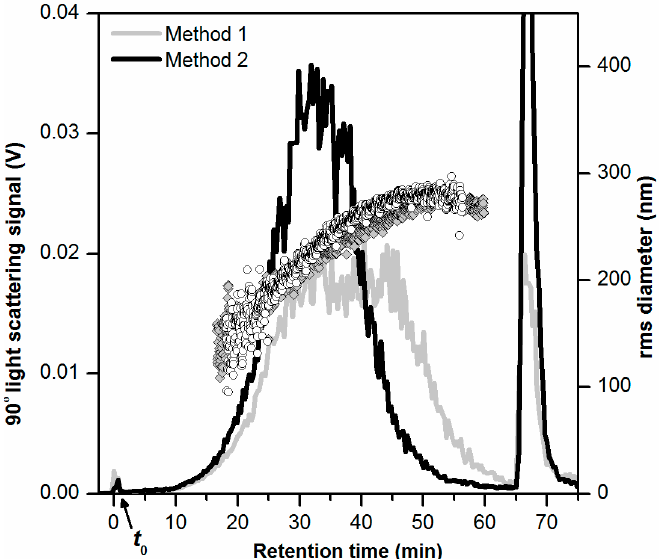
Figure 1. AF4 ‐ LS fractograms obtained for toothpaste dispersions (carrier liquid 0.05% w/w SDS, 10 μ g injected toothpaste mass) prepared by a two ‐ step dilution in 0.1% w/w SDS (method 1, gray line) and chemical oxidation with 30% H 2 O 2 followed by dilution in 0.1% w/w SDS (method 2, black line). The rms diameter values obtained by MALS are shown as gray diamonds and black circles, respectively. The AF4 ‐ LS measurements were performed on different AF4 membranes.